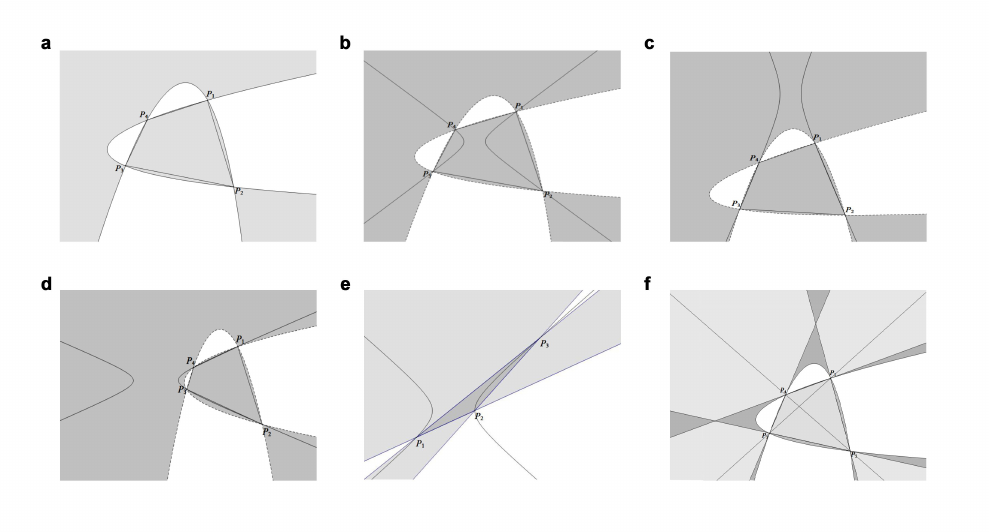
Figure 3: Circumscribed conics of convex quadrilaterals. (a) The coverage area of the circumscribed hyperbolas of a general convex quadrilateral is the shaded part. (b,c) “2+2” hyperbola, which means two vertices are on one branch while the other two are on the other branch. (d) “4+0” hyperbola, which means all of four vertices are on one branch. (e) There exists no “3+1” hyperbola which is circumscribed about a convex quadrilateral. (f) The “2+2” hyperbolas cover the light grey area, while the “4+0” hyperbolas cover the dark grey